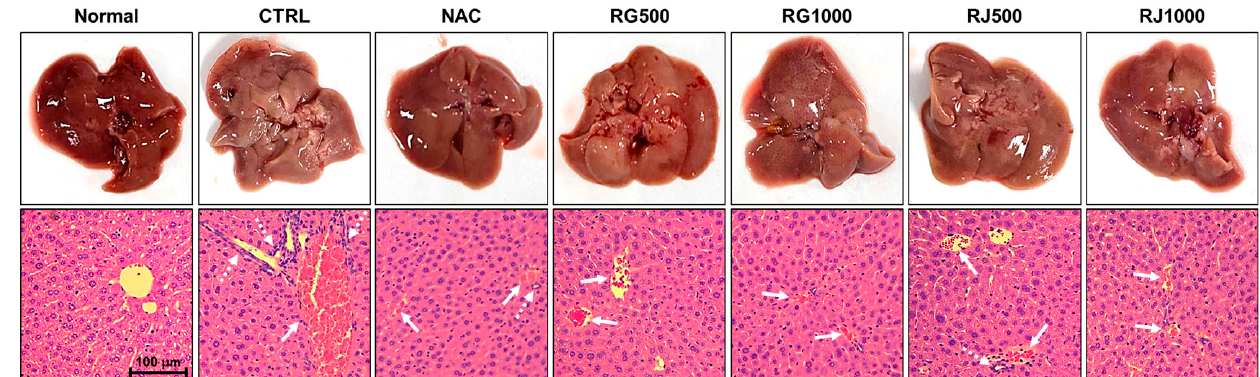
Figure 3. Effects of radish extracts on hepatic histology (hematoxylin and eosin staining) in APAP- induced liver-damaged mice. 200 × magnification. Congestion of central vein (white arrow), neutro- phils infiltration (white dotted arrow). ( n = 7) CTRL, control; NAC, N-acetyl cysteine; RG, turnips of Ganghwa; RJ, radishes of Jeju.